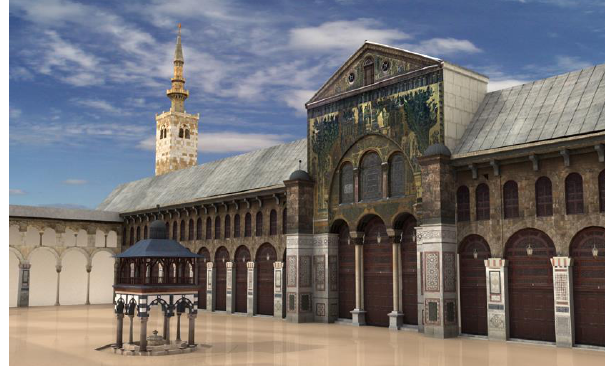
Figure 25 – The Umayyads mosque (plot and render by